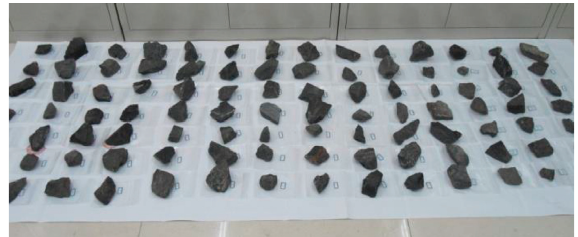
Figure 1: Irregular magnetite ore samples.